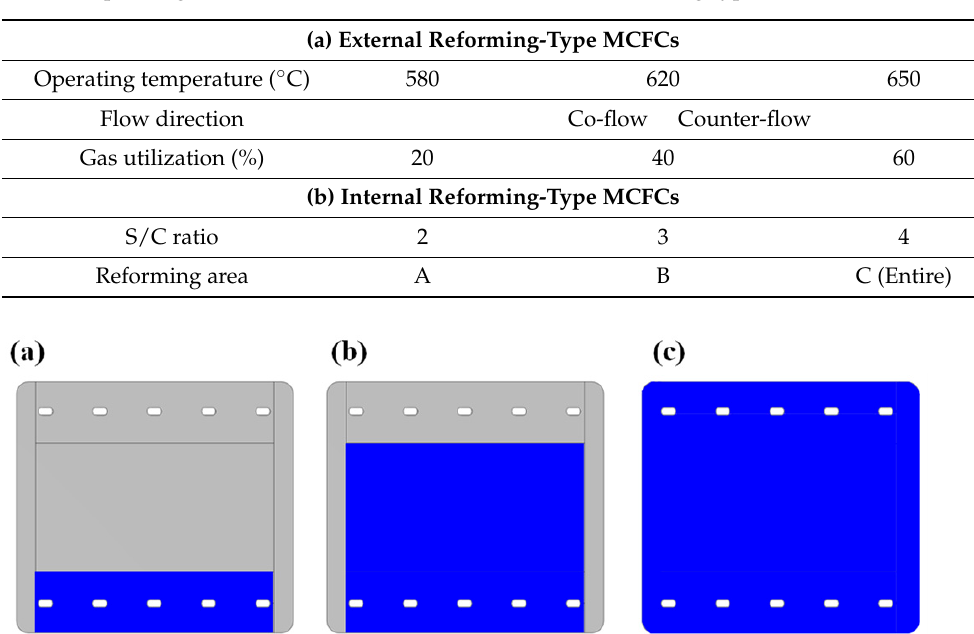
Table 2. Operating conditions in ( a ) external and ( b ) internal reforming-type MCFCs.